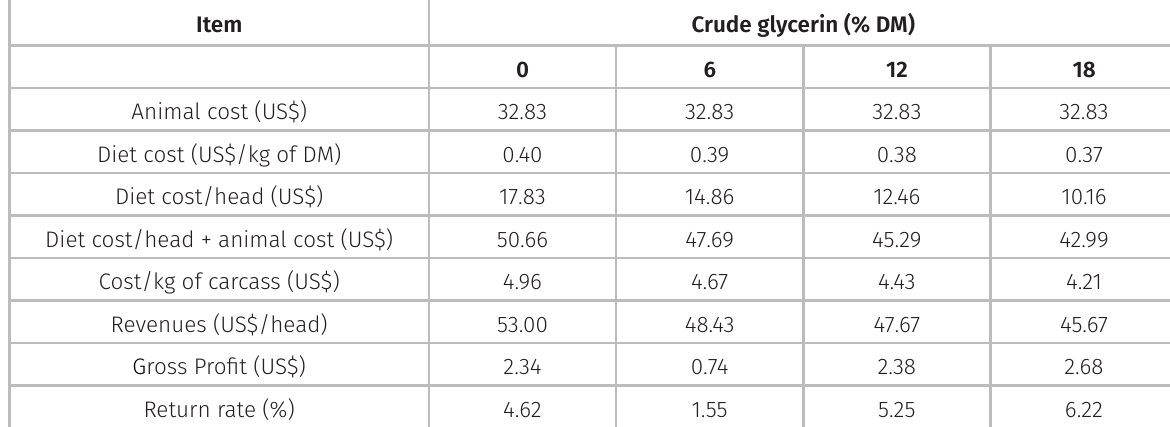
Table VI. An economic evaluation of goats fed diets containing increasing levels of crude glycerin containing 63.06% glycerol and 45.57%